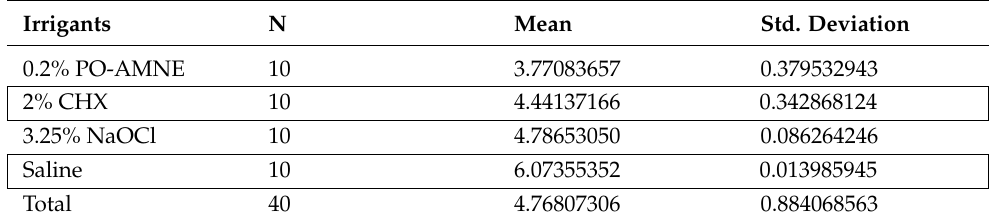
Table 9. Mean and standard deviation of irrigants against S. epidermidis at 200 µ m. Irrigants N Mean Std.